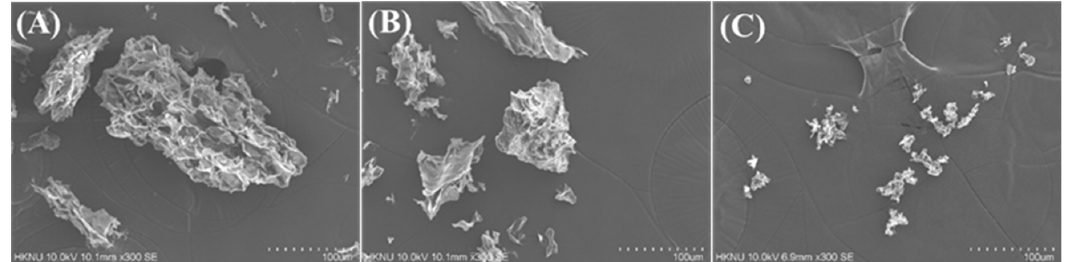
Figure 4. Scanning electron micrographs of ( A ) coarse, ( B ) fine and ( C ) superfine mushroom powders at 300× magnification. The white button mushrooms were UV-B treated for 30 min and freeze-dried before pulverization.